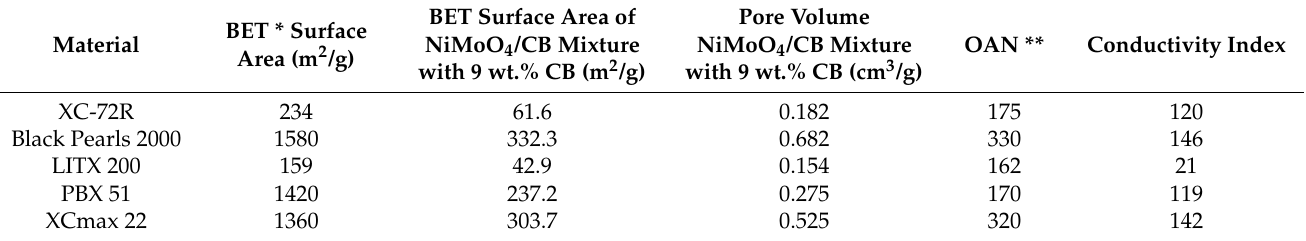
Table 2. Specific surface area, pore volume, oil absorption number (OAN), and conductivity index of the studied pristine CB types. BET surface area and pore volume of a NiMoO 4 /CB mixture with different CB types and a CB loading of 9 wt.%.